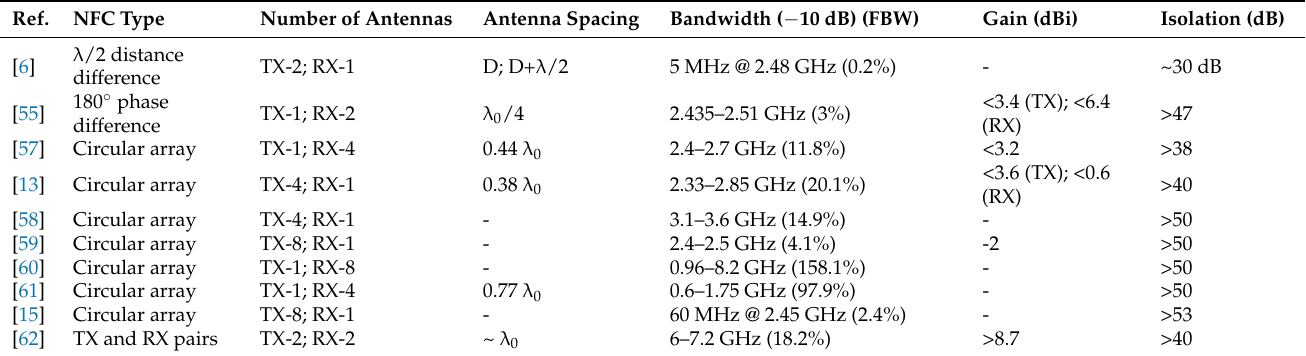
Table 2. A comparison of IBFD antennas based on near-field cancellation